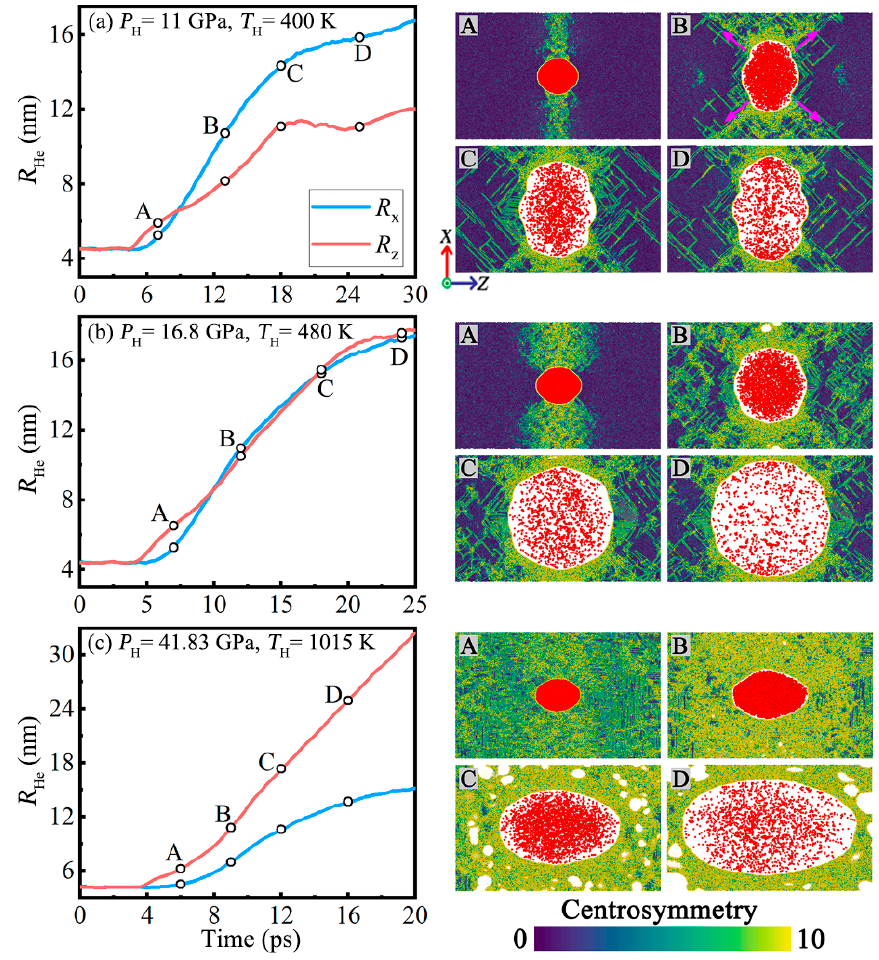
Figure 3. The bubble radius and corresponding microstructure evolutions for three typical Hugoniot states. ( a – c ) shows the radius evolution of the He bubble in the x direction and z direction (release direction) during release from different Hugoniot states. The right figures (A-D) present the micro- structure at several moments corresponding to the marked points on the left figure, where the atoms are color-coded by CSP.